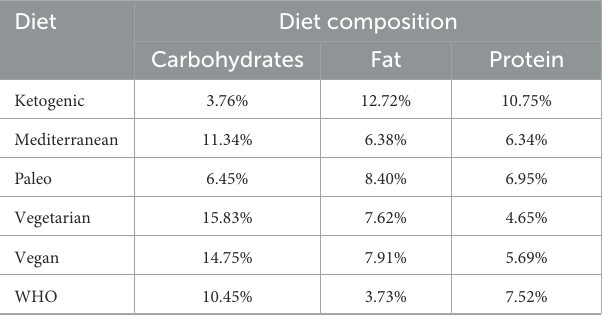
TABLE 1 Proportion of carbohydrates, fat, and protein in each diet, for 1 week of food at 2,000 kilocalories/day.